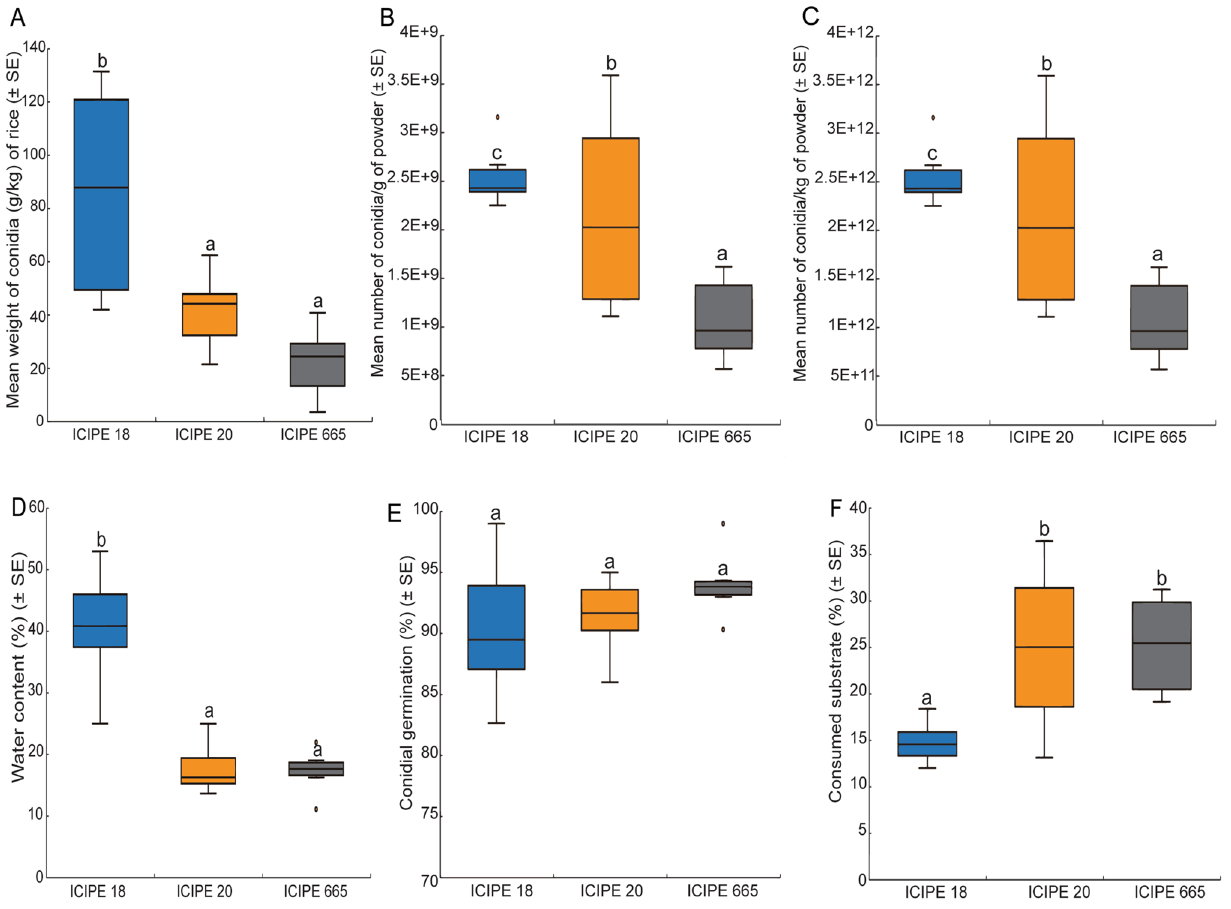
Figure 6. Mass-production indices of Metarhizium anisopliae isolates ICIPE 18, ICIPE 20 and ICIPE 665. ( A ) Mean weight of conidia powder/kg of rice. ( B ) Mean number of conidia/g of powder. ( C ) Mean number of conidia/kg of powder. ( D ) Water content (%) of conidia. ( E ) Percentage conidial germination and ( F ) Percentage consumed substrate. Different lowercase letters above error bars indicate a significant difference across the treatments (n = 18; N = 6; Tukey’s HSD test). Middle quartile (line that divides the box into two parts) shows midpoint of the data. Middle box represents 50% of the scores for each treatment and the middle 50% values fall within the inter-quartile